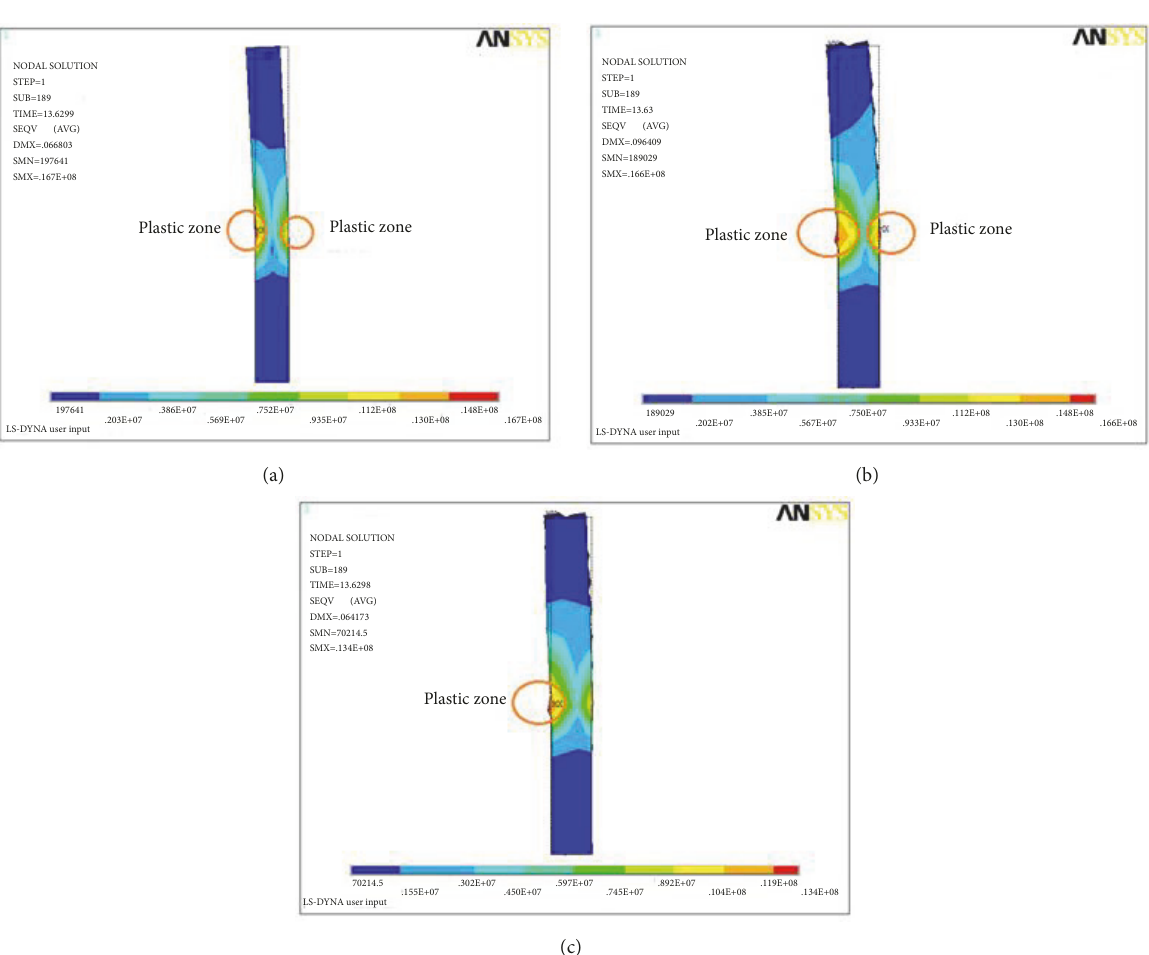
Figure 20: The equivalent stress cloud diagram of stabilizing pile in different working conditions. (a) Different section sizes; (b) different PGAs; (c) different material